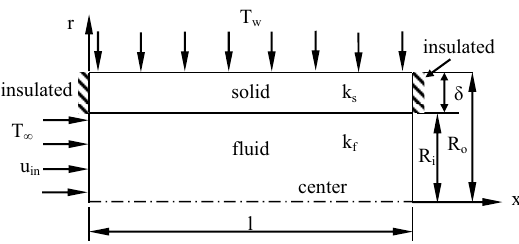
Figure 1: Geometry details, coordinate system, and boundary